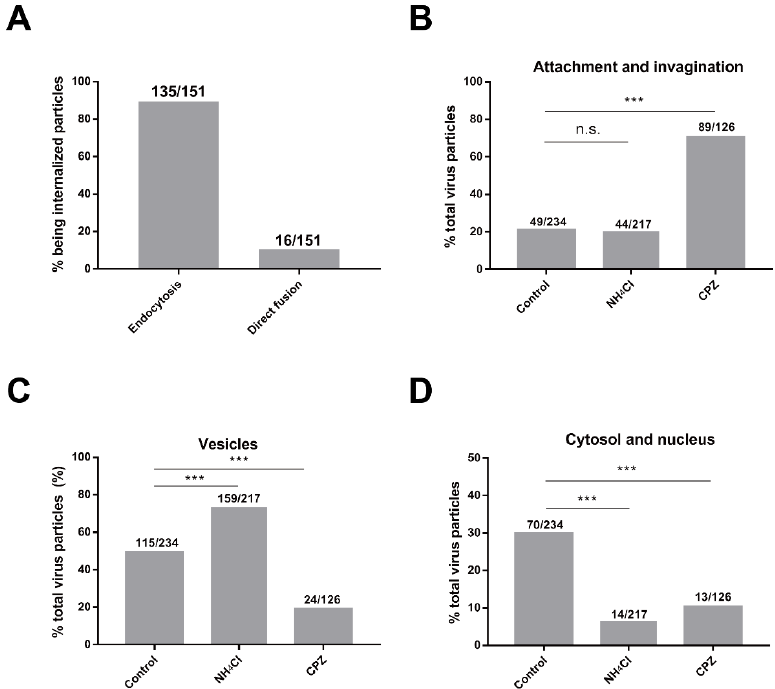
Figure 6. Quantitative ultrastructural analysis of AcMNPV entry into Sf9 cells. Sf9 cells were pretreated with CPZ or ammonium chloride (NH 4 Cl) before infection. The inhibitors were present throughout the experiment. Sf9 cells without pretreatment with inhibitors were included as a control. Quantitative analysis of about 200 cell sections was performed for each group. All the virus particles observed, such as intact viral particles and nucleocapsids without envelope, were recorded for analysis. ( A ) The percentage of virus particles that entered via endocytosis and direct fusion with the plasma membrane over the particles being internalized. ( B – D ) Three different stages of viral infection were observed and analyzed: the percentage of internalization (attachment to the plasma membrane and invagination, ( B ), trafficking in vesicles (single and multiple virus particles, ( C ), and the presence of nucleocapsid in the cytosol and nucleus ( D ). *** indicates p < 0.001, Pearson χ 2